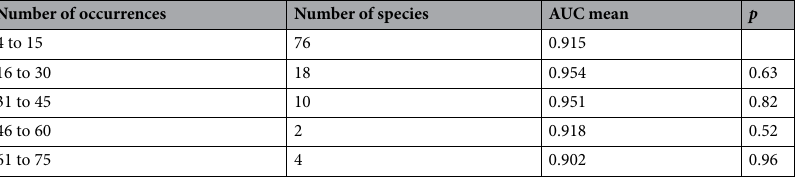
Table 1. Values of Monte Carlo tests performed to identify the relationship between the numbers of occurrences and the observed AUC values. AUC area under the